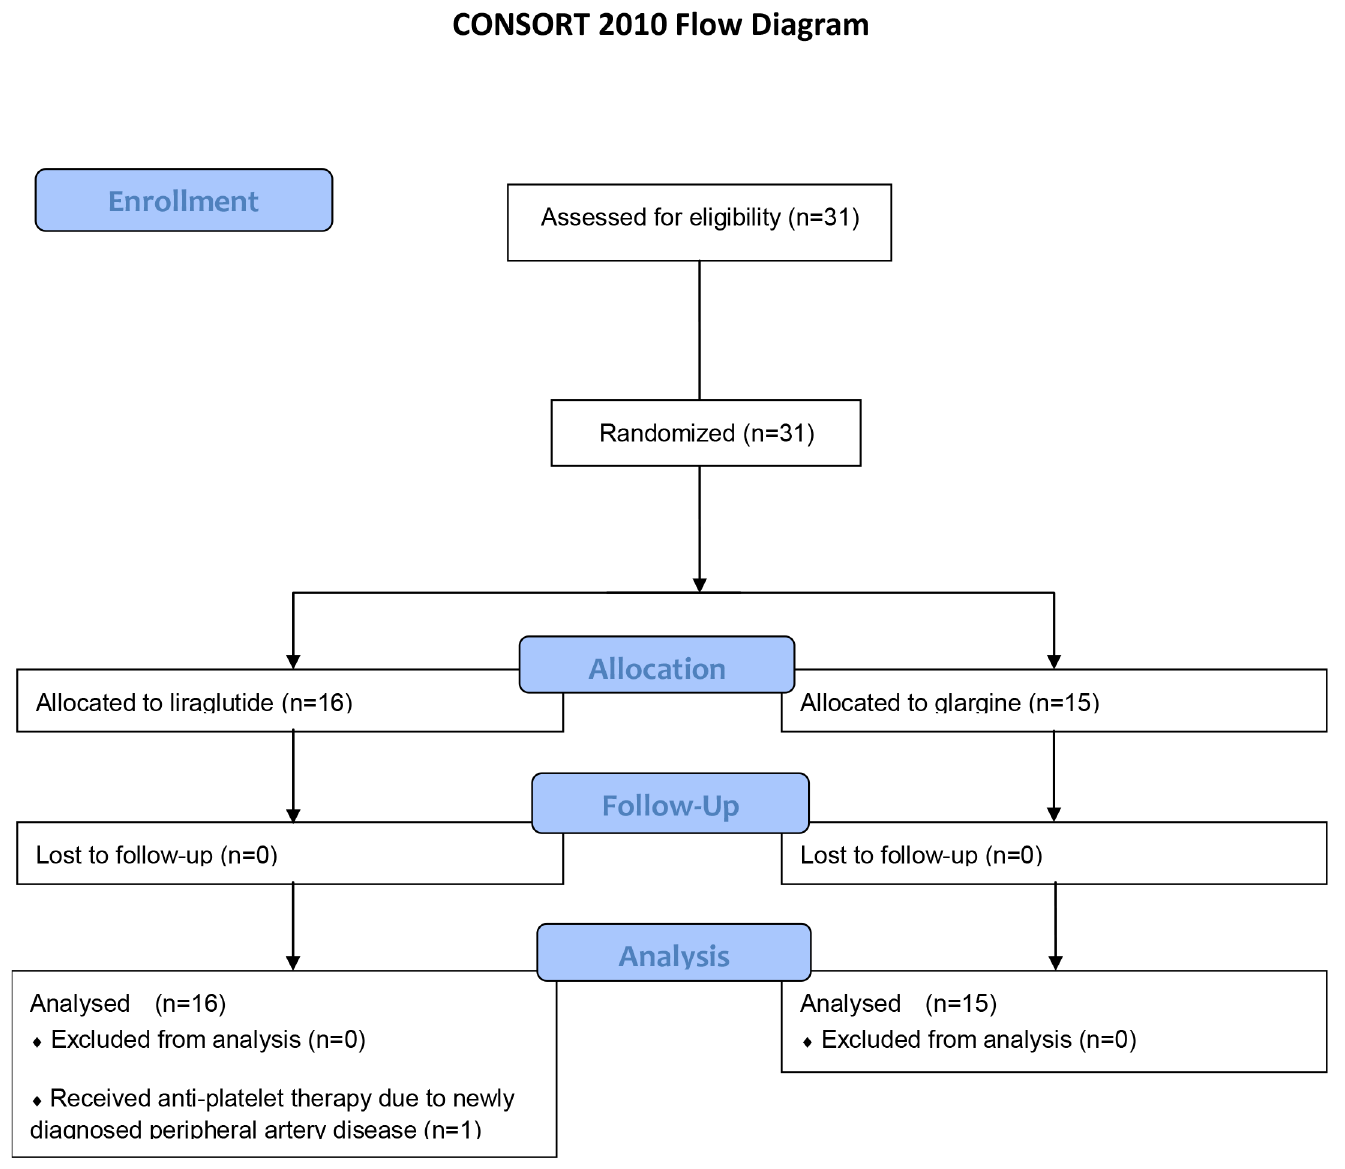
Fig 1. CONSORT Flowchart Participant Flow and